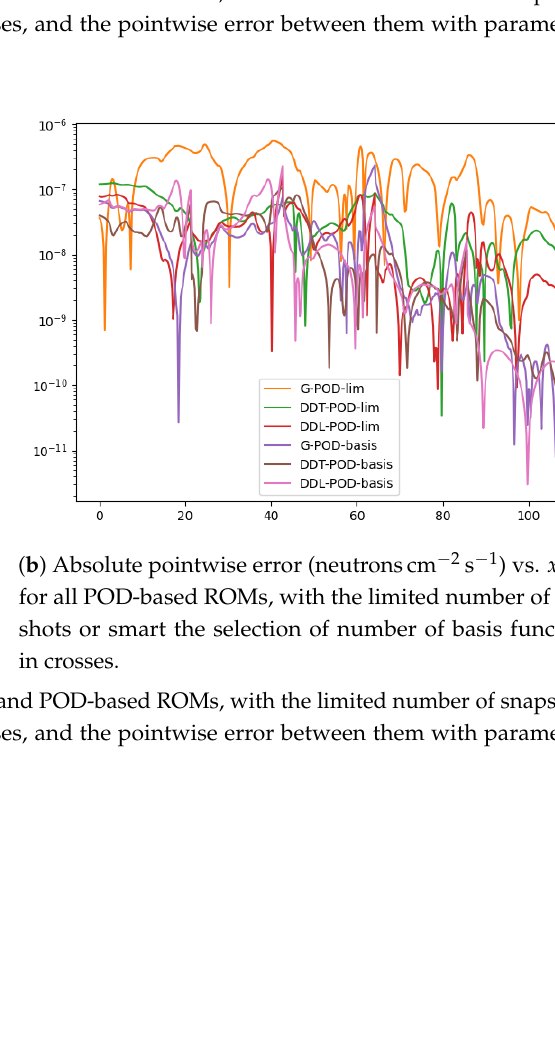
for all POD-based ROMs, with the limited number of snap- shots or smart selection of the number of basis functions, in crosses.